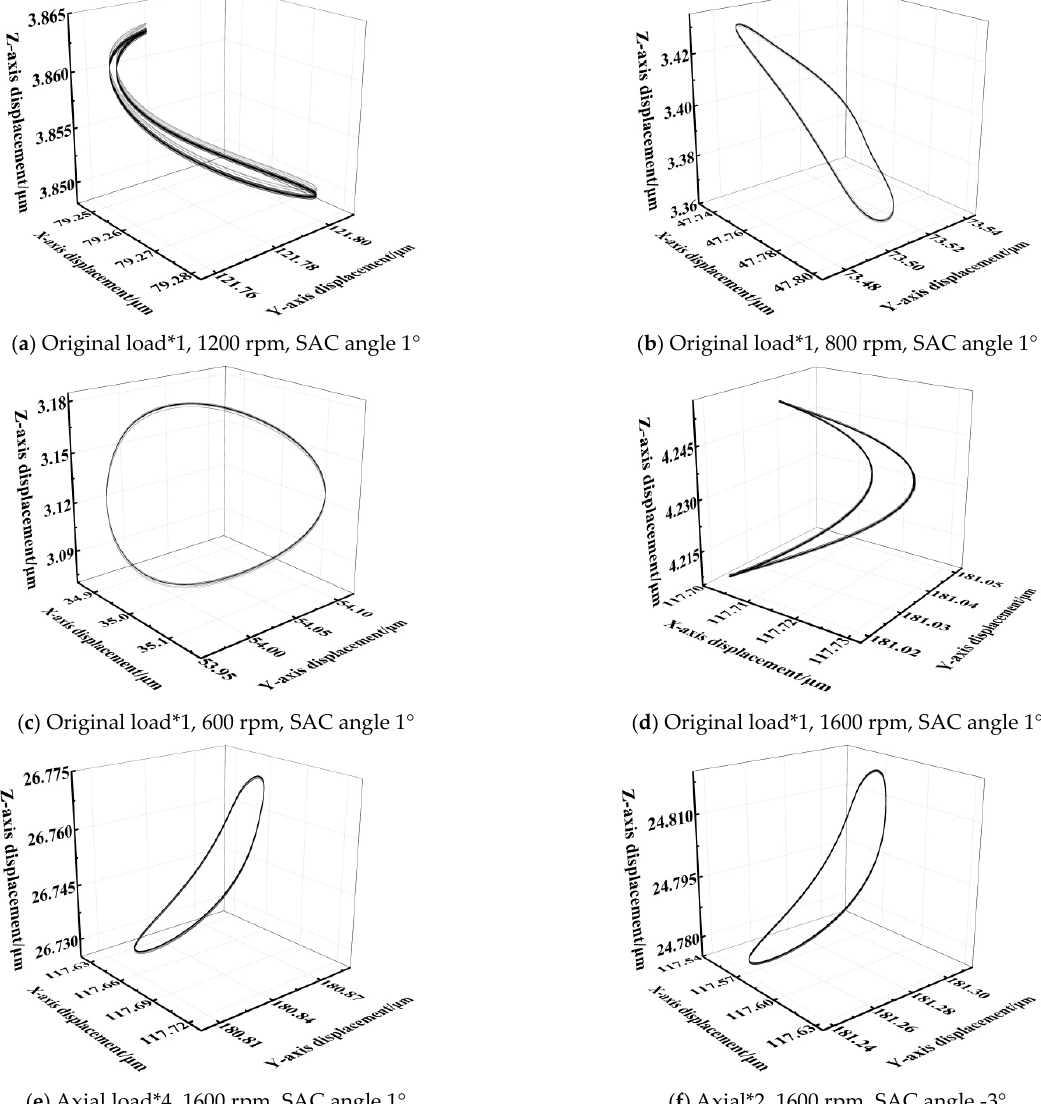
Figure 20. The motion orbit of the inner ring with different external loads, rotating speeds, and SAC angles. SAC